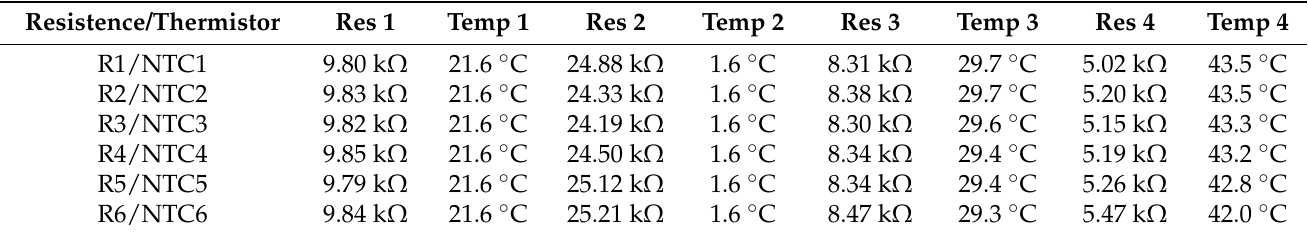
Table 3. Data of resistances (Res 1 to 6) and temperatures (Temp 1 to 6) taken by the six NTC sensors. Resistence/Thermistor